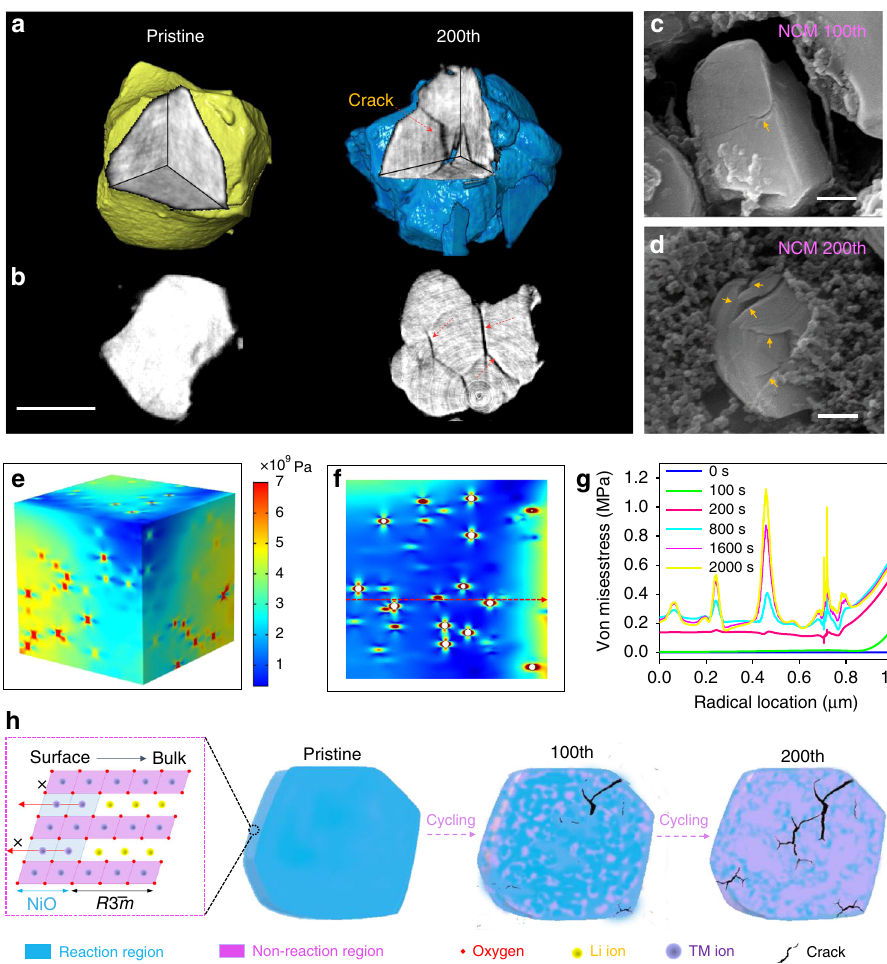
Fig. 6 3D reconstruction and structural degradation mechanism. a, b X-ray nano-tomography reconstruction with volume rendering shows the morphological evolution of NCM after cycling. Scale bars 2 μ m. c , d SEM images of the NCM microsphere after 100 and 200 cycles. Scale bars 500 nm. Equivalent stress within the NCM particles: e 3D semitransparent view. f 2D view of the cross pro fi le. g Von Mises stress within the NCM particles along the imaginary line. h structural degradation mechanism in